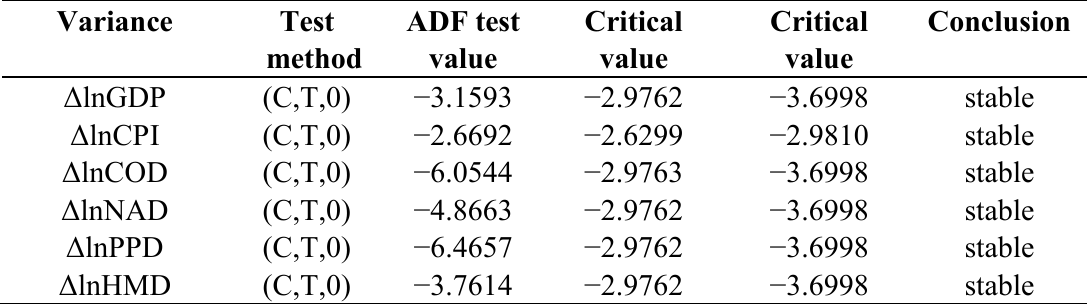
Table 1. Results of the unit root